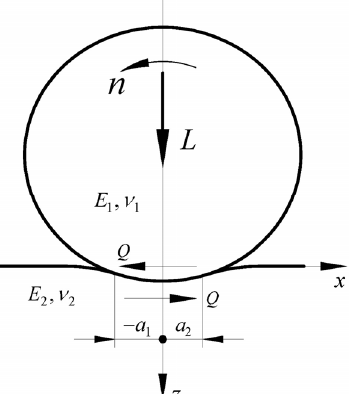
Fig. 2 Diagram of a contact between two elastic bodies. and a half-infinite plane. L is the normal load per unit length, Q is the tangential traction due to friction and n is the rotation speed. E Young’s moduli and the Poisson’s ratios of contact bodies, respectively. The initial contact point is set as the origin of the coordinate. a are the left and right contact width, respectively.